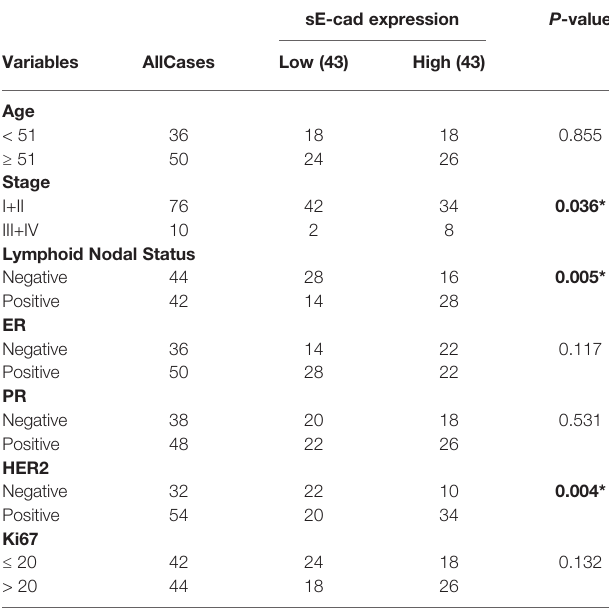
*Signi fi cantly different. ER,estrogenreceptor;PR,progesteronereceptor;HER2,humanepidermalgrowthfactor receptor 2; Ki-67, proliferating antigen Ki67. *Bold values indicate P < 0.05.